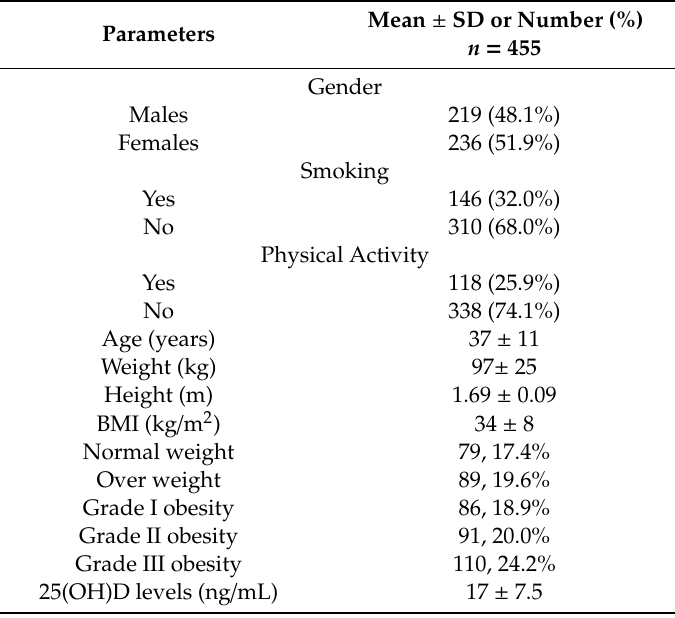
Table 1. Gender, lifestyle habits, age, anthropometric characteristics, and 25(OH)D levels of the study